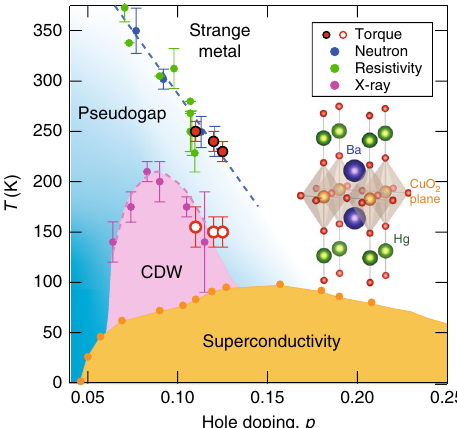
Fig. 1 Temperature-doping phase diagram of Hg1201. Orange fi lled circles represent T c (see the Methods section). Blue and green fi lled circles represent the pseudogap onset temperature T * determined by neutron scattering 17,18 and resistivity measurements 24 , respectively. Purple fi lled circles show the CDW onset temperature T CDW determined by resonant X- ray diffraction 6,7 . Red fi lled circles represent the onset temperature of diagonal nematicity determined by in-plane torque magnetometry, which lies on the pseudogap line (blue dashed line). Red open circles represent the temperature at which a suppression of the nematicity occurs, which is close to T CDW . The inset shows the crystal structure of Hg1201